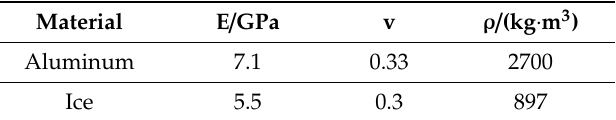
Table 2. Material